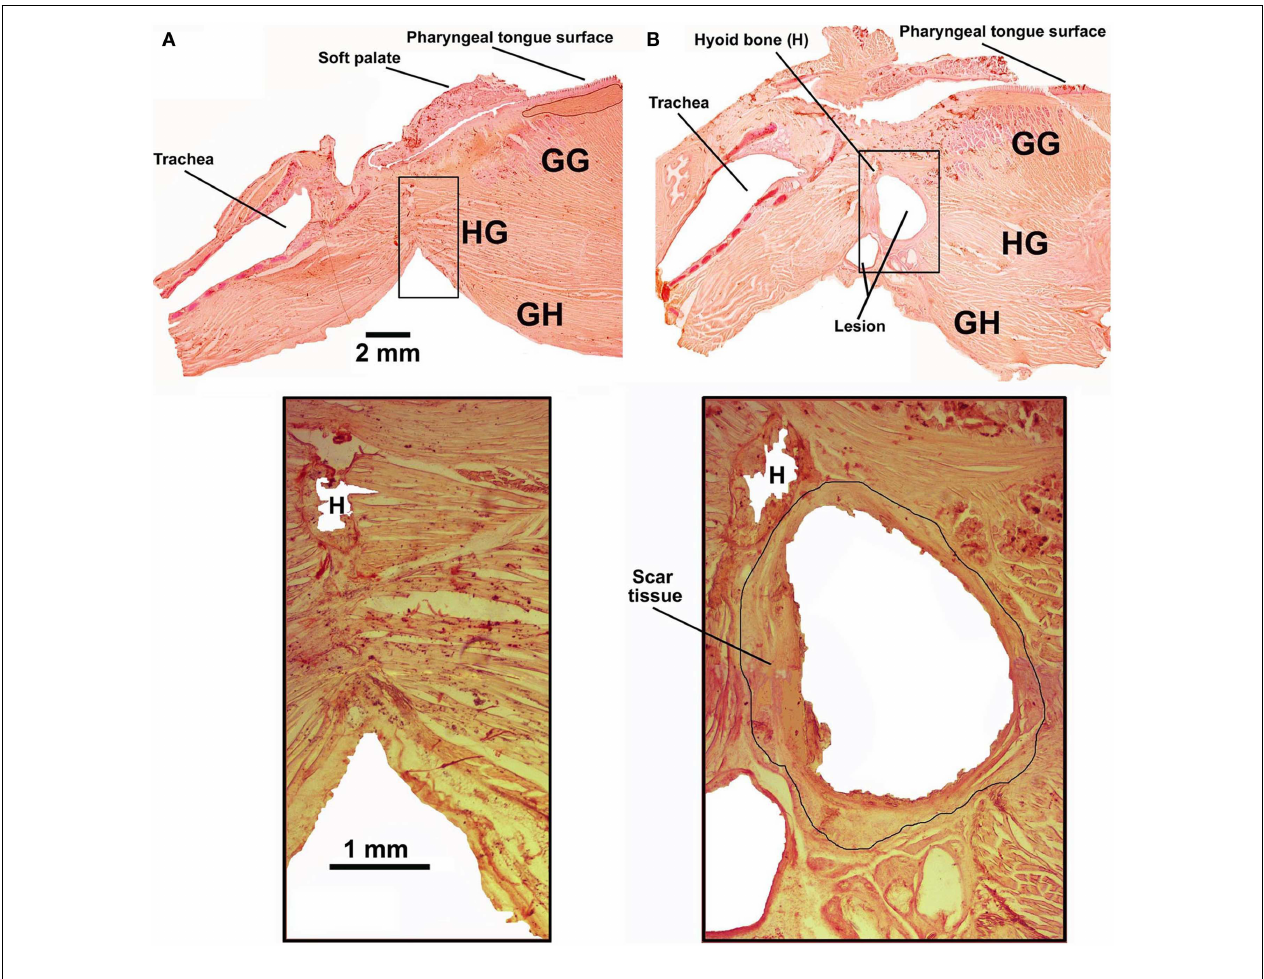
re-connection in the rats with compromised upper airway. In all rats with altered upper airway, the wax barrier remained in place and GH/HG muscles ended with a healed scar [black circle around the lesion in the enlarged image in (B) ], with no evidence of re-connection to their original insertion